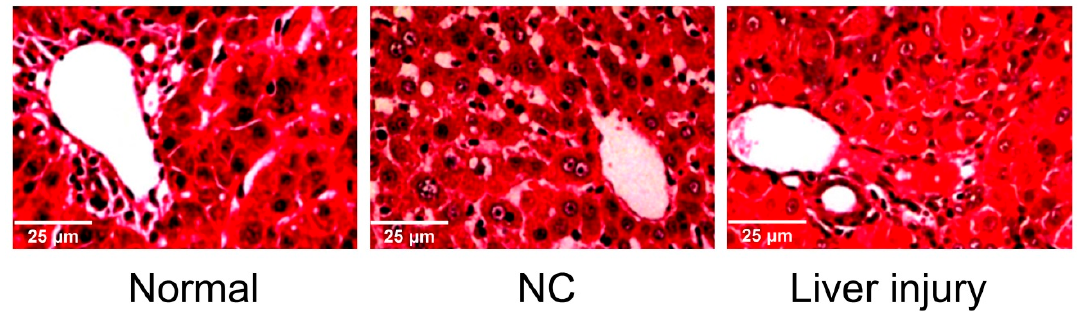
Figure 1. Liver tissues are disorderly arranged in rats with liver injury and appeared ductular reaction. HE, hematoxylin-eosin; NC, negative control by polyethylene glycol (PEG) solution. Ten rats in each group. Scale bars represent 25 μ